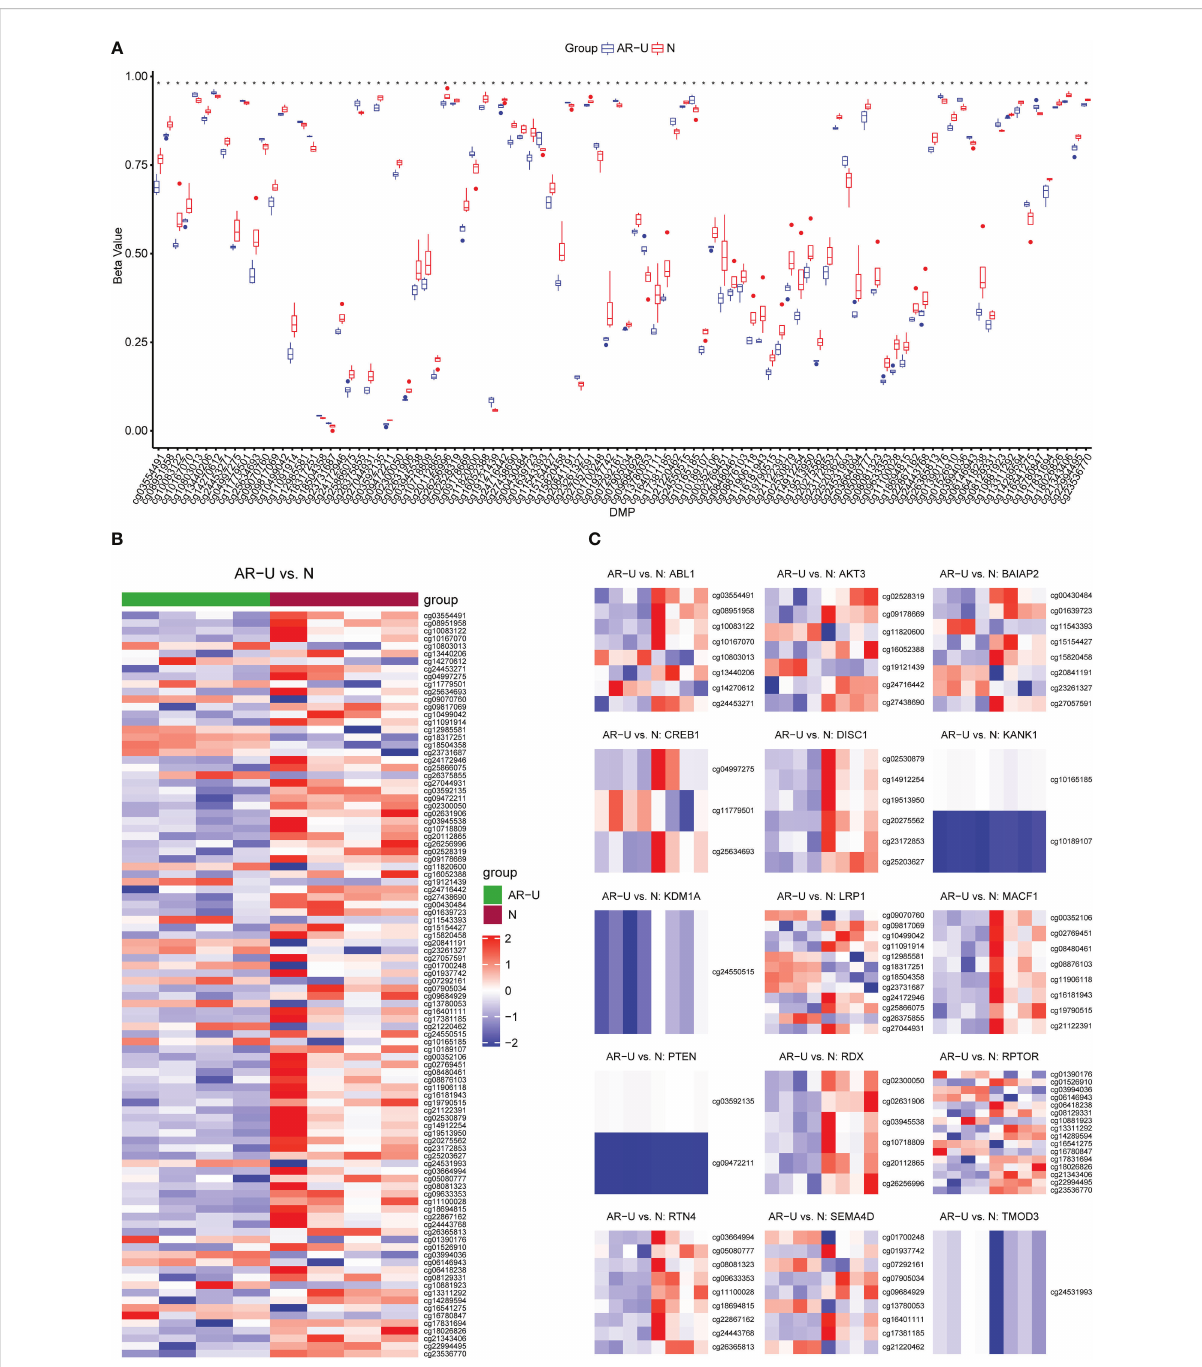
FIGURE 9 Identi fi cation and veri fi cation of DMPs. (A) Overview of methylation rates for 98 CpGs in the box plot. (B) Heatmap of 98 differentially methylated CpGs between AR-CSU patients and healthy individuals. (C) Heatmap of DNA methylation levels of different CpGs on the corresponding